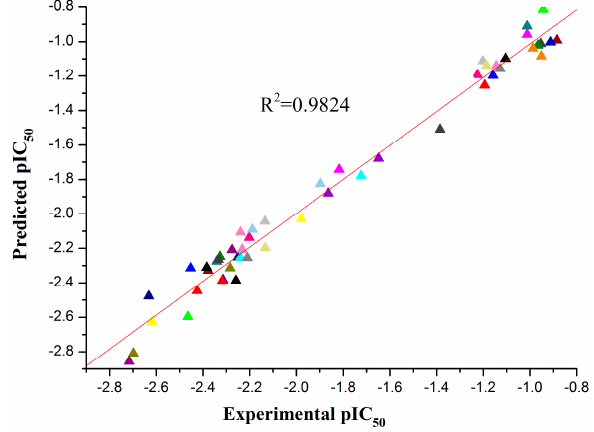
Figure 3. Experimental pIC 50 vs. predicted pIC 50 .